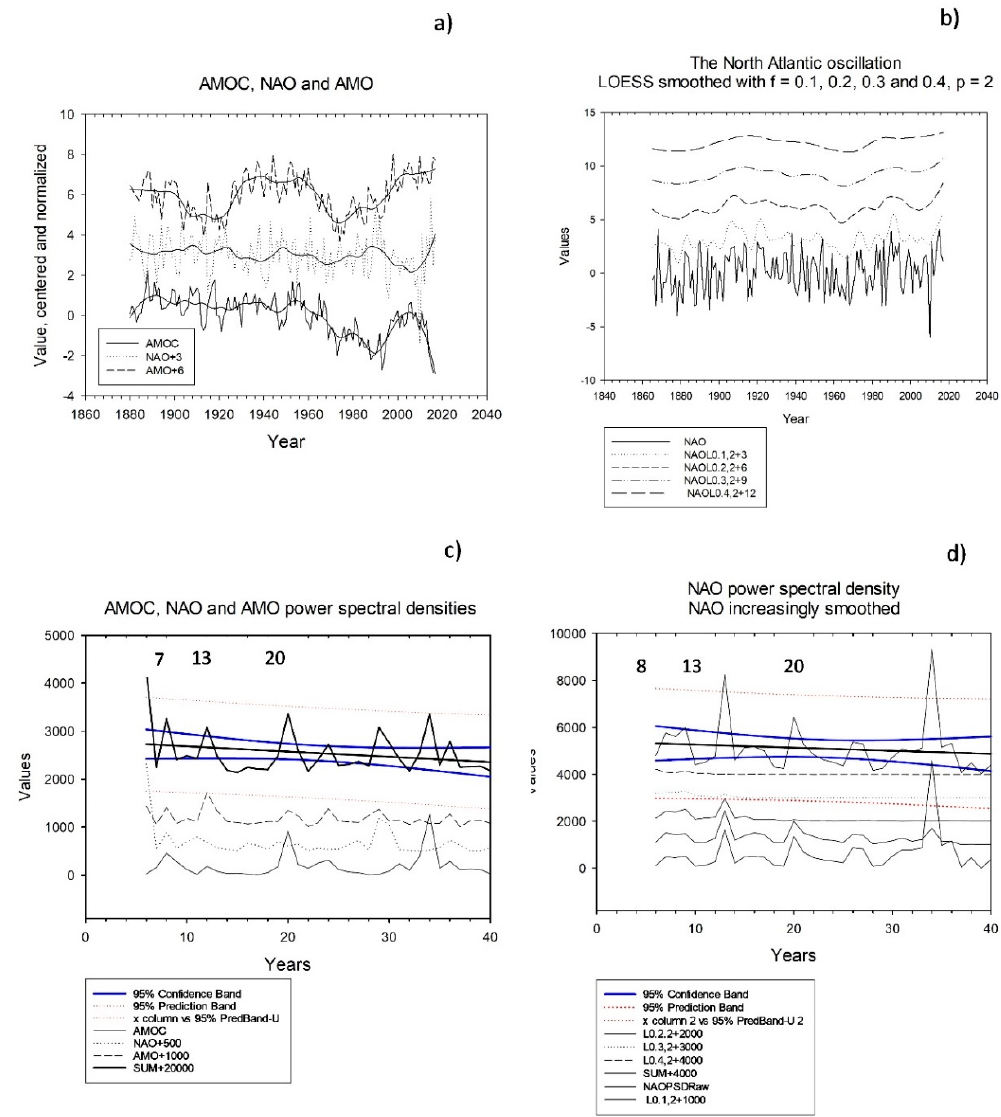
Figure 1. Time-series and their power spectral densities. ( a ) Time-series for the AMOC, the NAO and the AMO, the full lines are LOESS (0.2, 2) smoothed versions; ( b ) Time-series for NAO, LOESS smoothed to different degrees. ( c ) Power spectral density for the AMOC, the NAO and the AMO and the three series superimposed. The three series show common pronounced peaks at 7 years 13 years, 19–20 years, 23–24 years, and 34–36 years; ( d ) Power spectral density for the NAO at different LOESS smoothing degrees. The time-series show pronounced peaks at 7–9 years, 13 years, 16 years, 20 years, 26–27 years, and 34–36